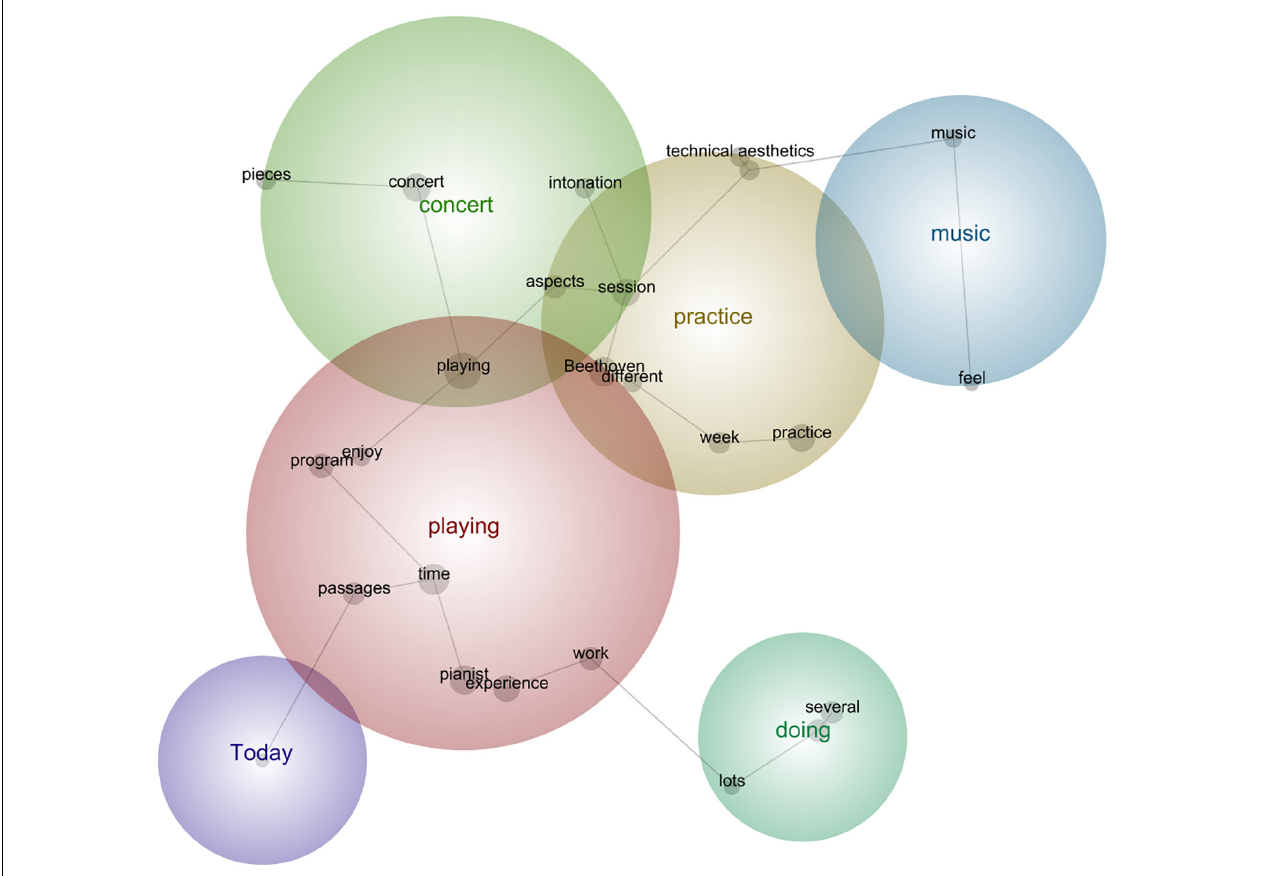
FIGURE 10 | Leximancer concept map for Concert